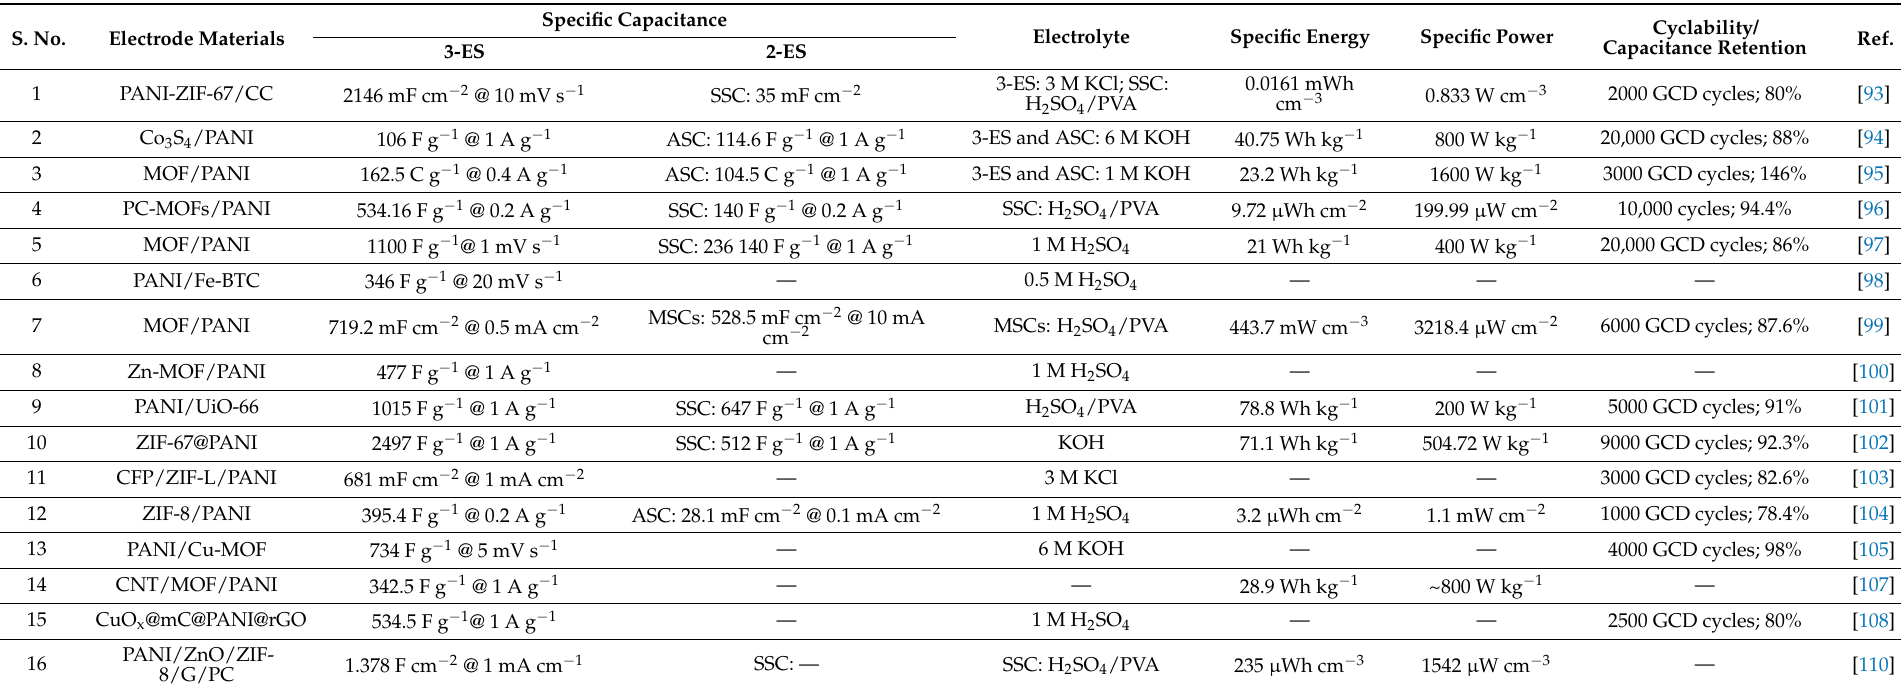
Table 1. PANI/MOF composite-based electrode materials for supercapacitor